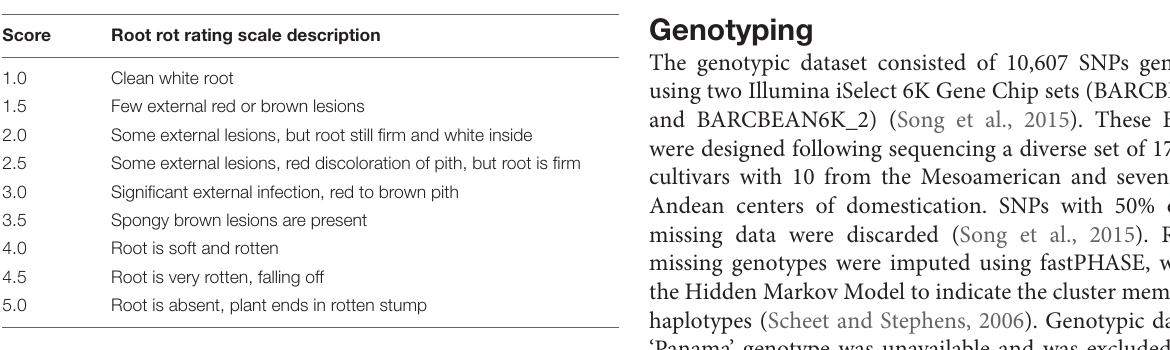
TABLE 1 | Scale for rating Fusarium solani root rot symptoms in the BeanCAP Snap Bean Diversity Panel grown at the Oregon State University Vegetable Research Farm for a genome wide association